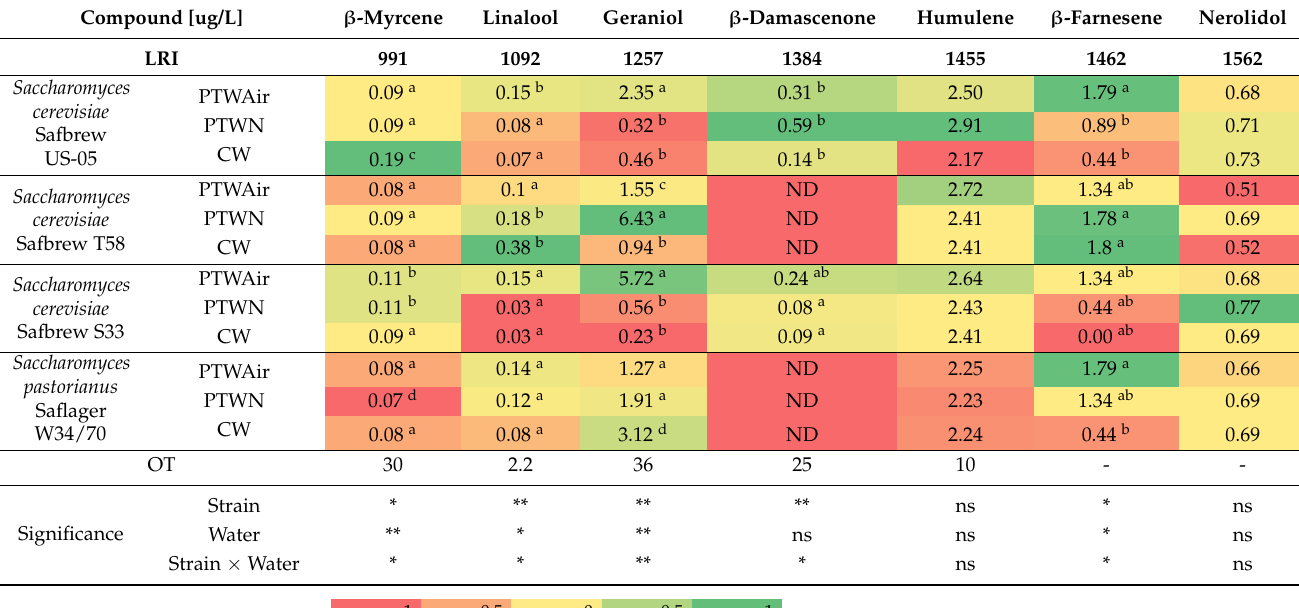
0 0.5 1 Values with different superscript roman letters (a–d) in the same column indicate statistically significant differences at p < 0.05; n = 4; ns—not significant; 0.001 ***; 0.01 **; 0.05 * ND- Not detected. LRI—linear retention index; the amount of components was determined. OT—Odour thresholds in beer [32]. Color determination from lowest (0%) to highest (100%) concentration of parameters. The lowest concentration of a specific parameter in each column is in the darkest red and the highest content is in the darkest green. Table 6. Terpenes in beers fermented by Saccharomyces cerevisiae (T58, US-05, S33) and